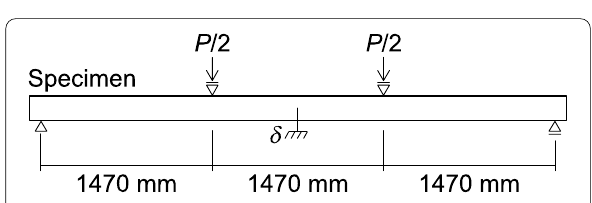
Fig. 2 Experimental setup for the short-term loading tests. P is load and δ is the displacement at a neutral axis of the specimen at span